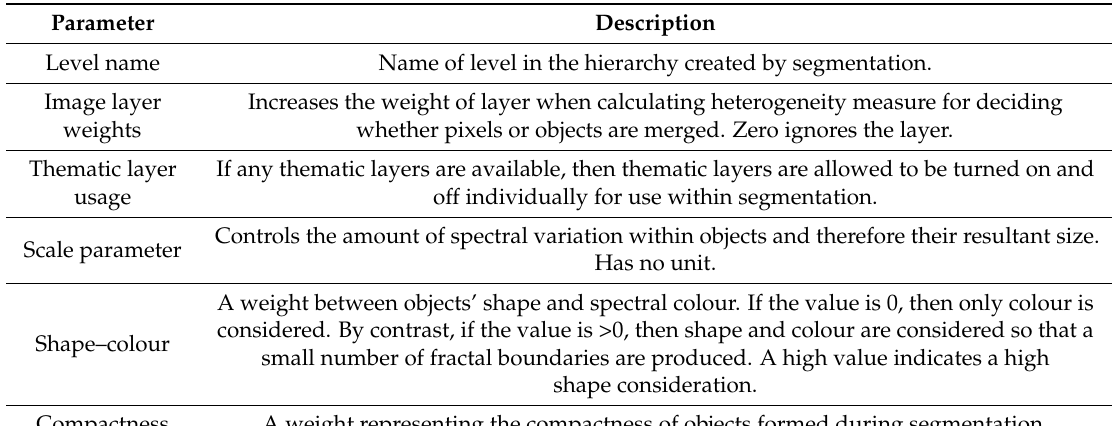
Table 3. Parameters for segmentation in parameter